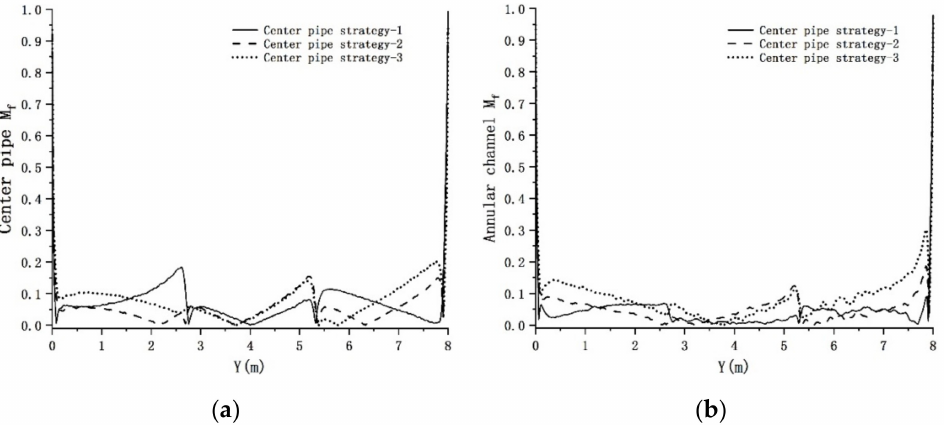
Figure 15. Non-uniformities for different Center pipe strategies: ( a ) non-uniformity at the location of the Center pipe, ( b ) non-uniformity at the location of the Annular pipe.